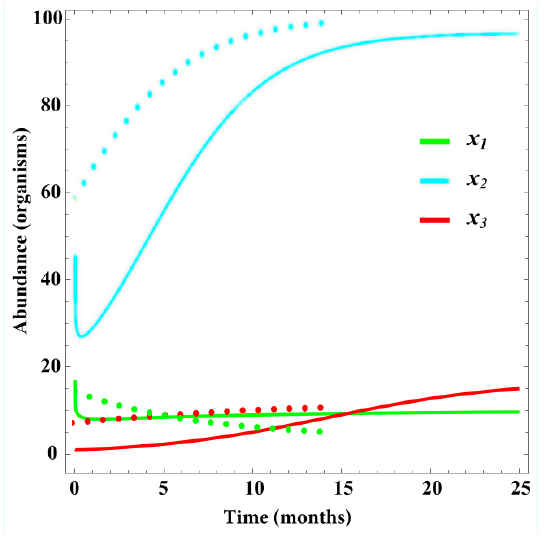
Figure 4. Population growth curves of observed vs. simulated data. The dotted lines do not consider the influence of the DO, while the continuous line curves do. Data from